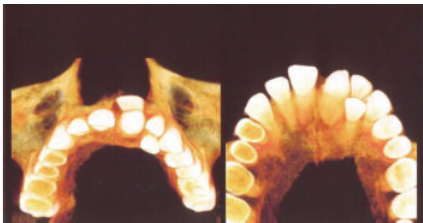
Figure 4: Panoramic radiograph showing erupted dilated odon- toma and supernumerary incisor with impacted maxillary central incisor.